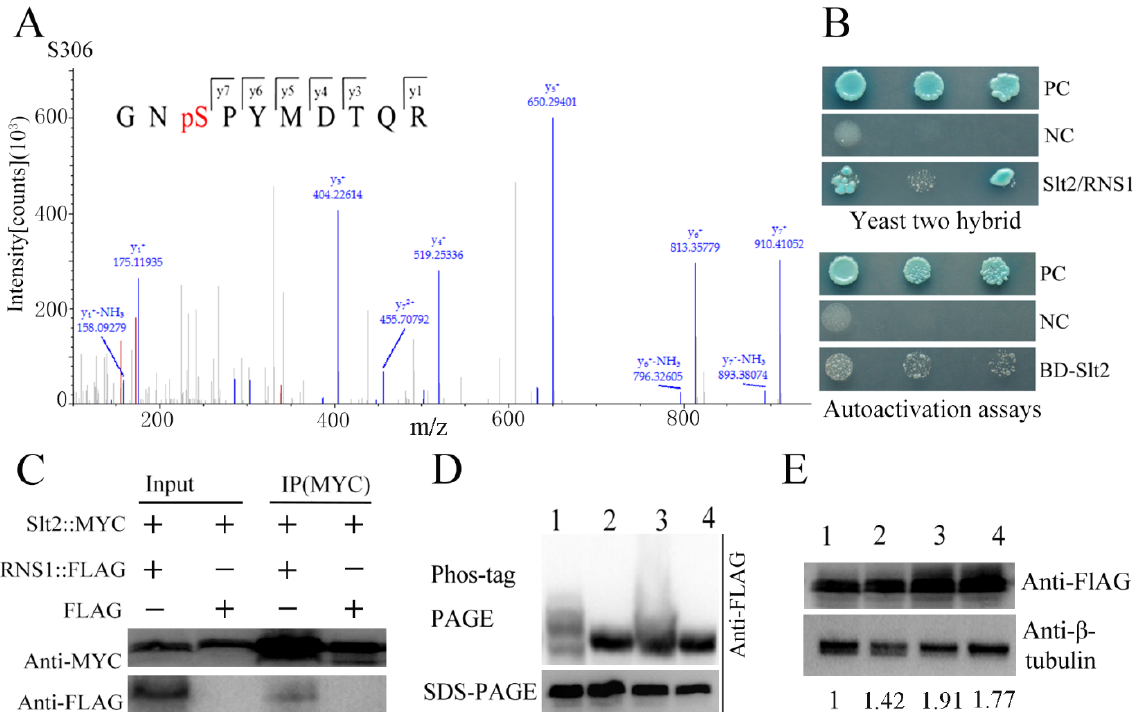
Figure 5. Phosphorylation of RNS1 by Slt2 during conidiation. ( A ) Phosphorylated peptide spectra identified by LC–MS/MS. The serine residue at position 306 was phosphorylated. The WT-RNS1-FLAG strain was used to conduct mass spectrometry assay. ( B ) Yeast two-hybrid analysis showing the physical interaction between the Slt2 and RNS1. Upper panel: colonies grown in SD-His-Ade-Leu-Trp + X- α -gal + AbA. Slt2/RNS1: cells expressing Slt2 and RNS1. Lower panel: colonies grown in SD-His-Trp-Ade plus X-a-Gal. BD-Slt2:: Y2HGold cells expressing Slt2; NC: negative control; PC: positive control. ( C ) Co-IP confirmation of the interaction of Slt2 and RNS1. Immunoprecipitation was conducted with anti-Myc antibody. Proteins were detected by immunoblot analysis with anti-Myc and anti-FLAG antibodies. ( D ) Phos-tag analysis of RNS1 phosphorylation by Slt2. Proteins were detected with the anti-FLAG antibody. (1) WT-RNS1-FLAG (RNS1::FLAG expressed in WT strain); (2) WT-RNS1 S306A -FLAG (RNS1 S306A ::FLAG (Ser-306 substituted to Ala in RNS1::FLAG) expressed in the WT strain); (3) ∆ Slt2-RNS1-FLAG (RNS1::FLAG expressed in ∆ Slt2 ); (4) ∆ Slt2-RNS1 S306A -FLAG (RNS1 S306A ::FLAG expressed in ∆ Slt2 . ( E ) Western blot analysis of the protein RNS1::FLAG in the strains WT-RNS1-FLAG , WT-RNS1 S306A -FLAG , ∆ Slt2-RNS1-FLAG and ∆ Slt2-RNS1 S306A -FLAG